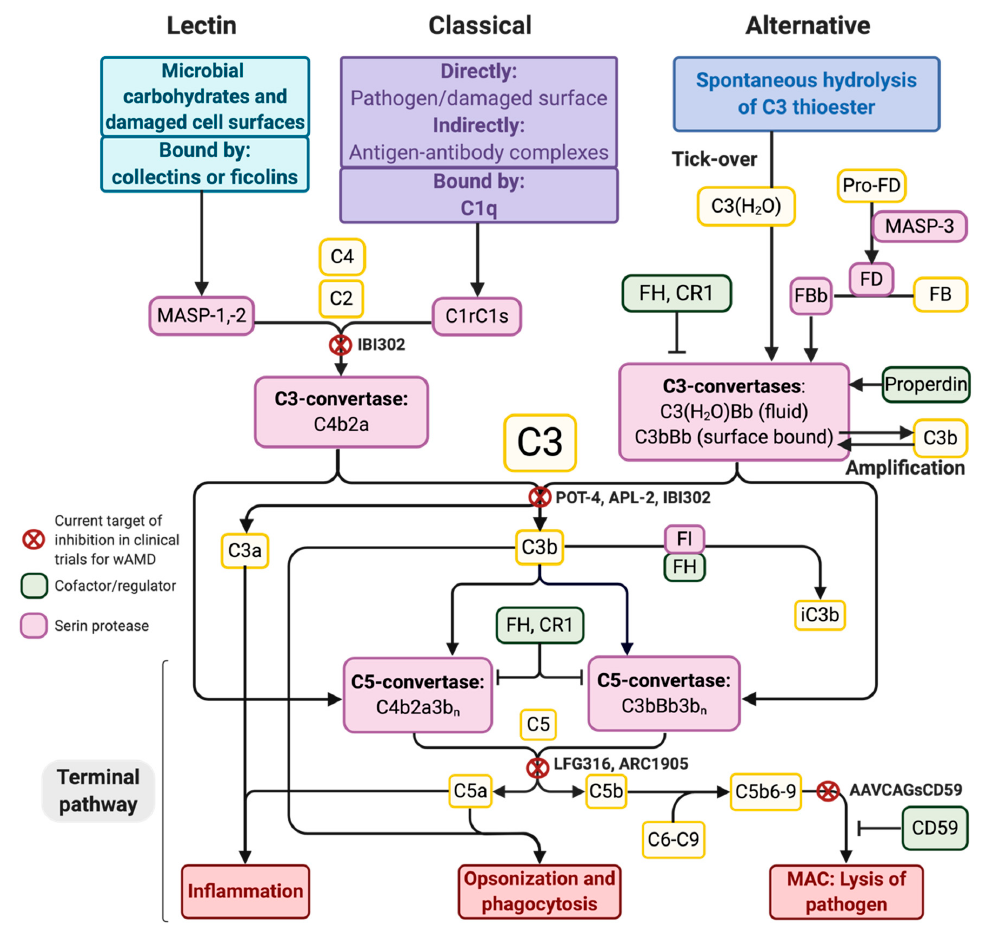
Figure 3. Overview of the complement components, regulators, and potential targets for inhibition.